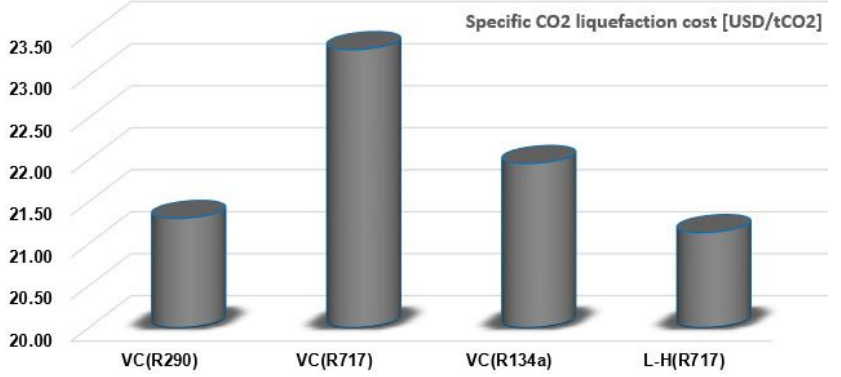
Figure 8. Relative results obtained from the economic analysis (VC R290 is assumed to be a reference case, 100%).